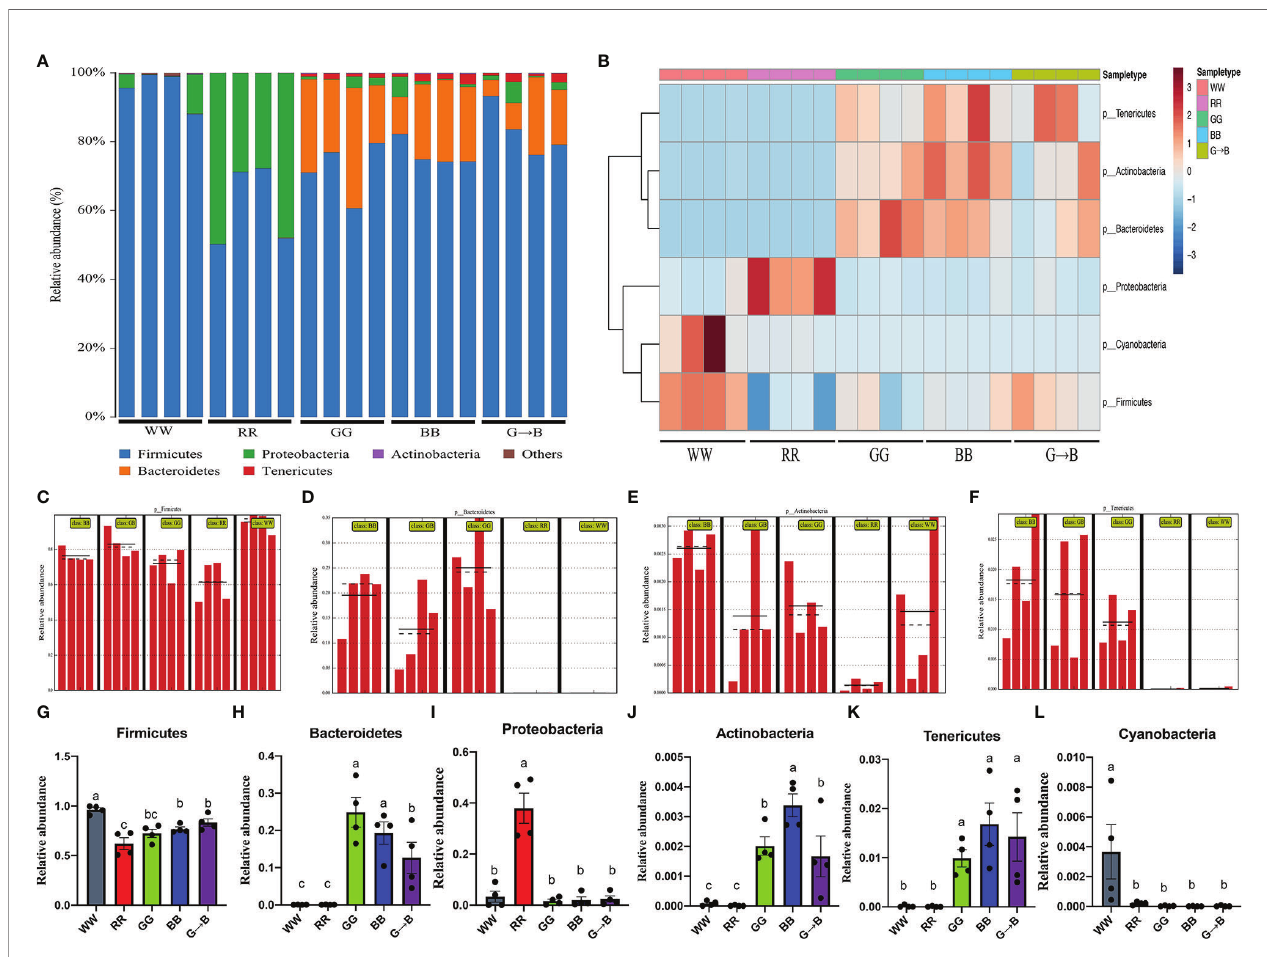
FIGURE 3 | Relative contribution of the top 10 phyla in chick cecum microbe of WW, RR, GG, BB, and G ! B groups at P42 (A) . Heat map of the redundancy analysis ‐ identi fi ed key phyla that were signi fi cantly altered in the chick cecum microbe of WW, RR, GG, BB, and G ! B groups at P42 (B) . Linear discriminant analysis effect size approach identifying the different phyla in the chick cecum microbe of WW, RR, GG, BB, and G ! B groups at P42 (C – F) . Taxonomic pro fi les of the notably signi fi cantly different bacteria at the phylum level in the chick cecum microbe of WW, RR, GG, BB, and G ! B groups at P42 (G – L) . The results are presented as means ± SEM. Different letters indicate signi fi cant differences between the treatments at the same age ( P <